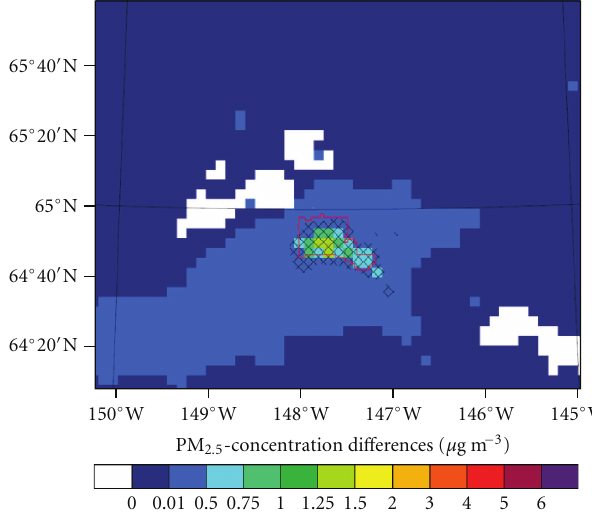
Figure 5: Zoom-in on the average di ff erences of PM 2 . 5 concentra- tion between REF and WSR for October to March. Hashed shading indicates grid cells with significant di ff erences at the 95% or higher level of